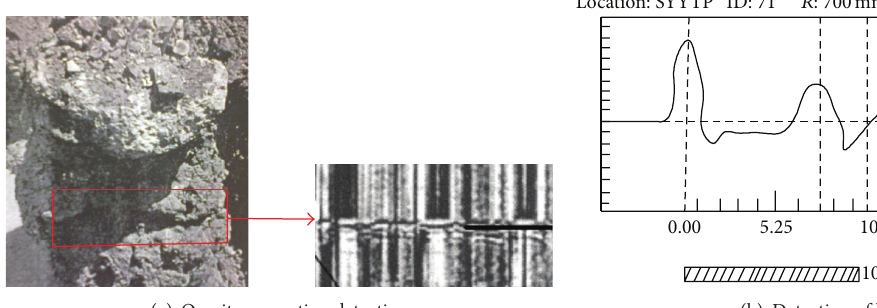
Figure 1: The actual damage of pile.